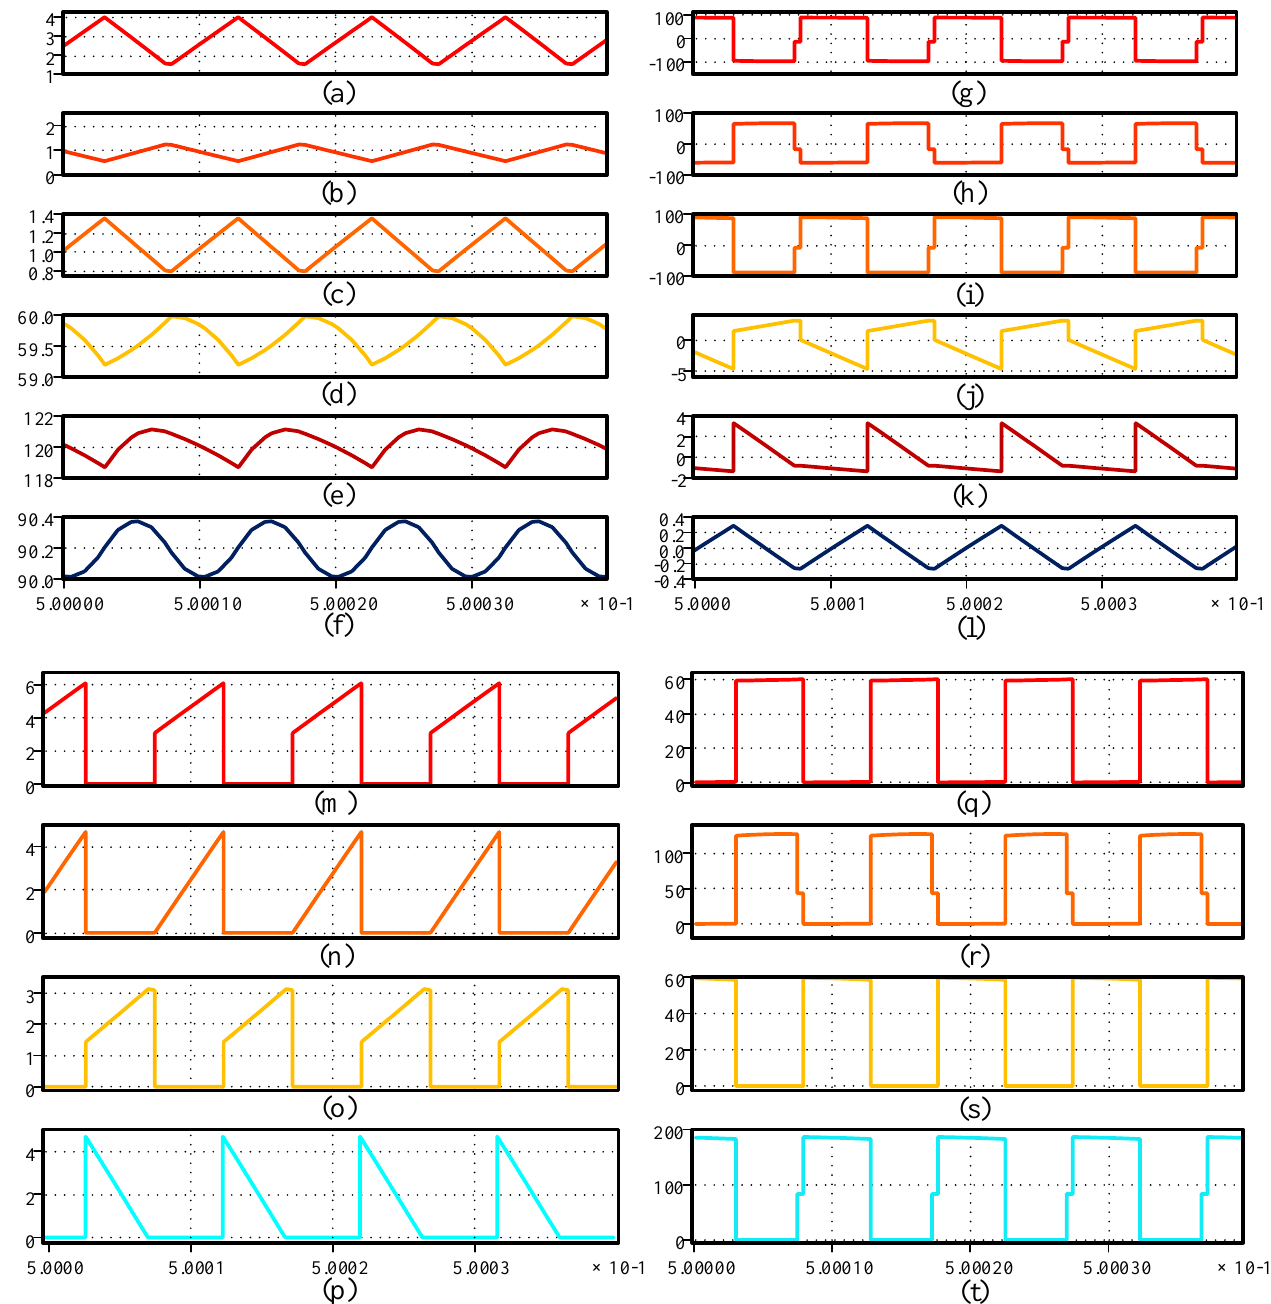
Figure 6. ( a ) First inductor current; ( b ) second inductor current; ( c ) third inductor current; ( d ) first capacitor